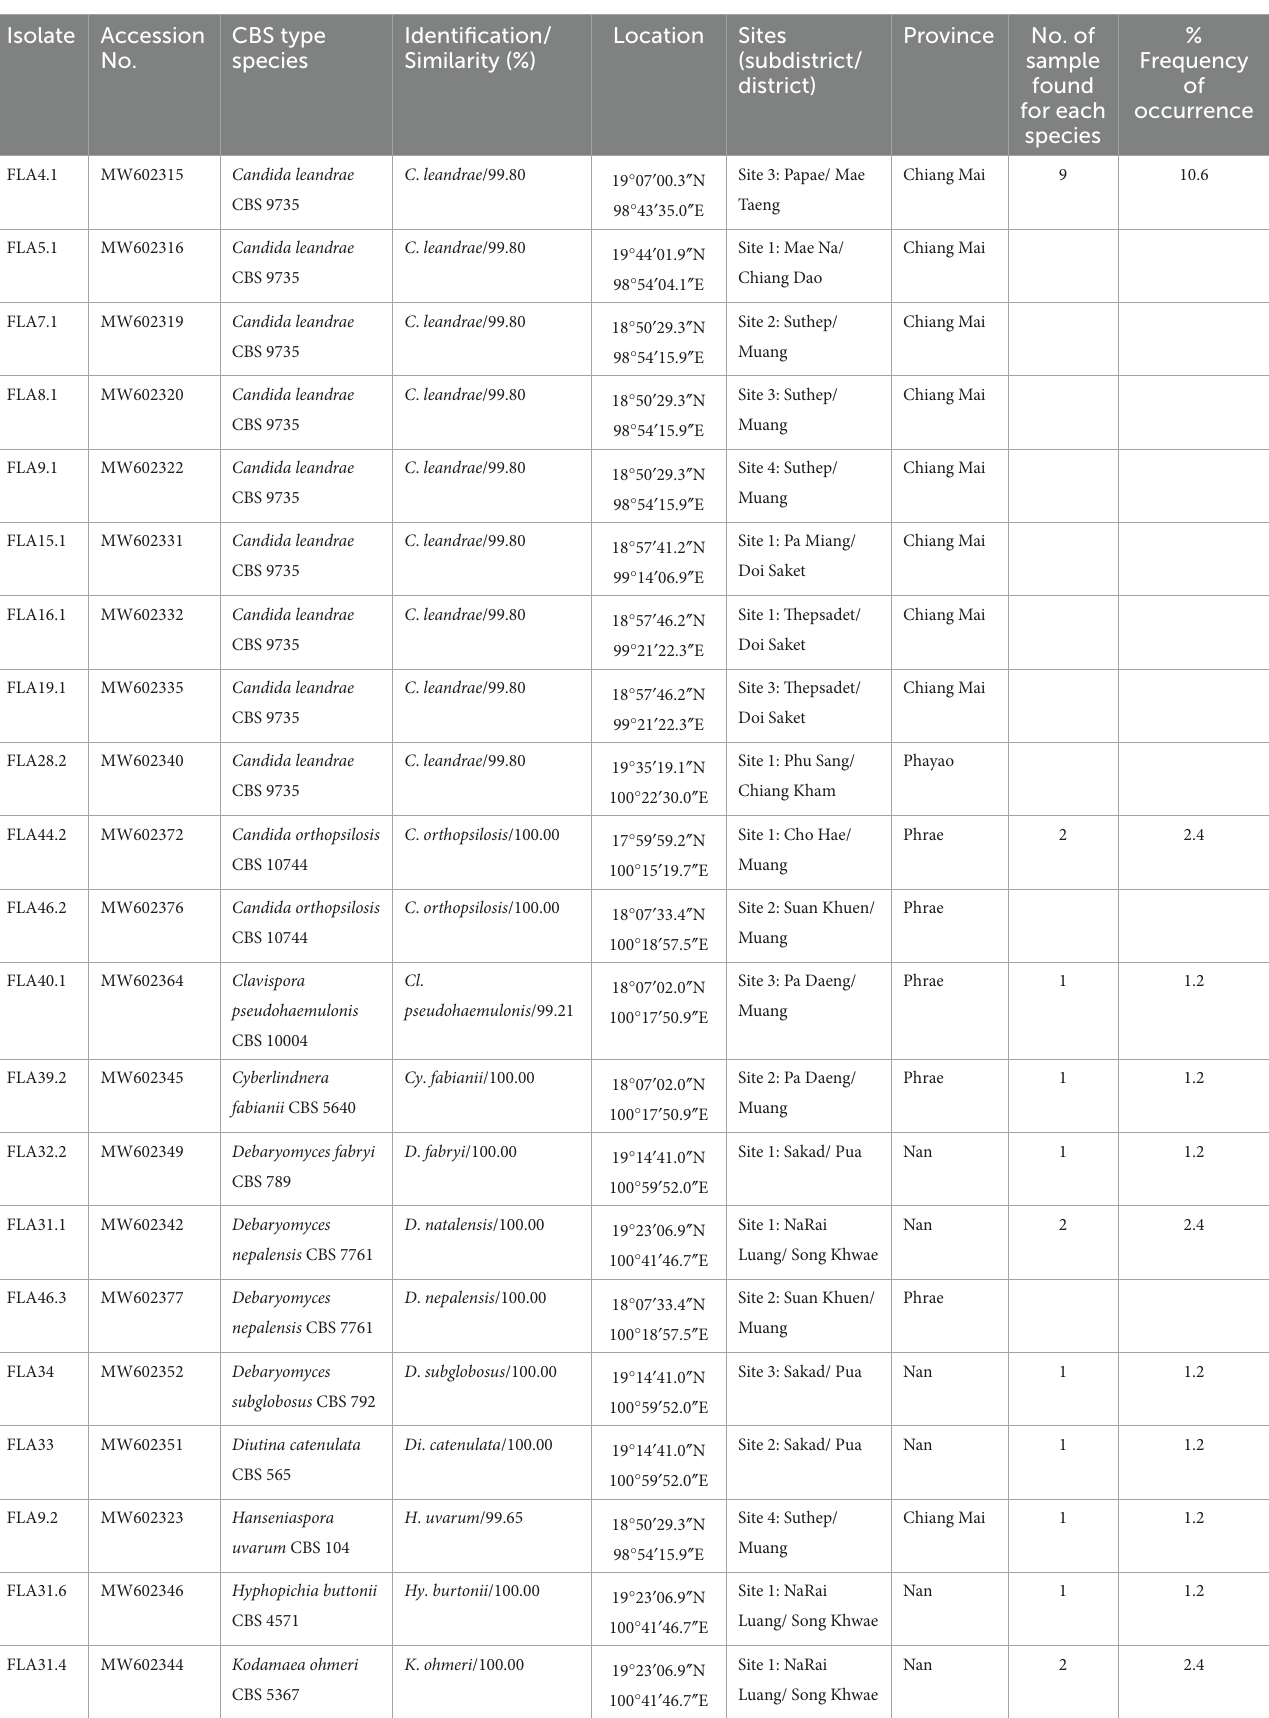
TABLE 1 Identification of yeast strains isolated from tea flower and their GenBank accession numbers of the D1/D2 domain of LSU rRNA gene. Isolate Accession